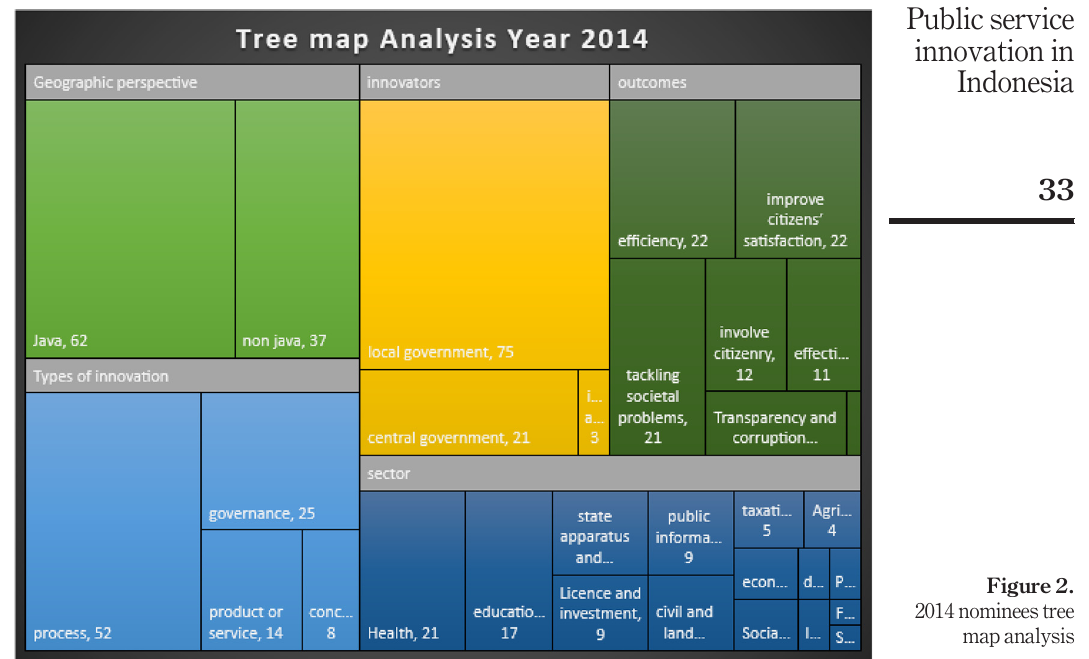
Figure 2. 2014 nominees